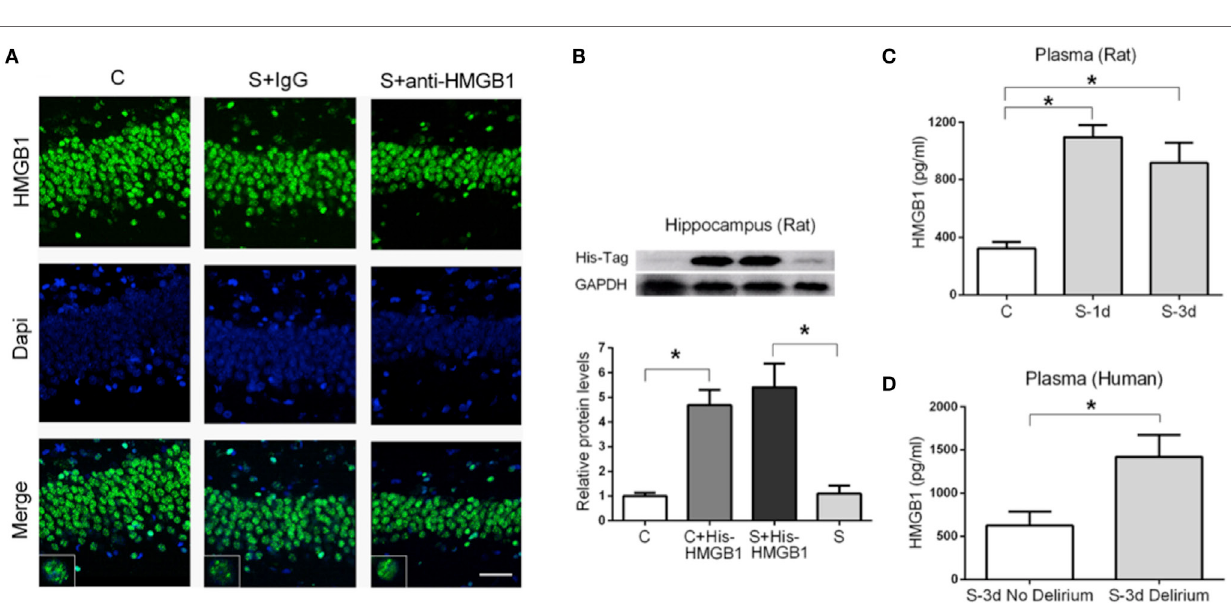
FigUre 5 | expression of hMgB1 in the hippocampus and plasma after surgery . HMGB1 localization in the hippocampus was assessed on postoperative day 3 (a) . No evident changes regarding nuclear translocation or extracellular HMGB1 were detected after surgery (S + IgG) or in S + anti-HMGB1 groups. Images and insets are representative of the hippocampal DG area. We used His-tagged HMGB1 to detect its presence in the CNS after tail vein administration (B) . Representative immunoblot and quantification show the presence of His-tagged HMGB1 in the hippocampus of both control (C + His-tagged HMGB1) and operated rats (S + His-tagged HMGB1). Systemic levels of HMGB1 in rats (c) and human (D) plasma were measured by ELISA on days 1 and 3 after surgery. Results are expressed as mean ± SEM. Scale bar = 50 μ